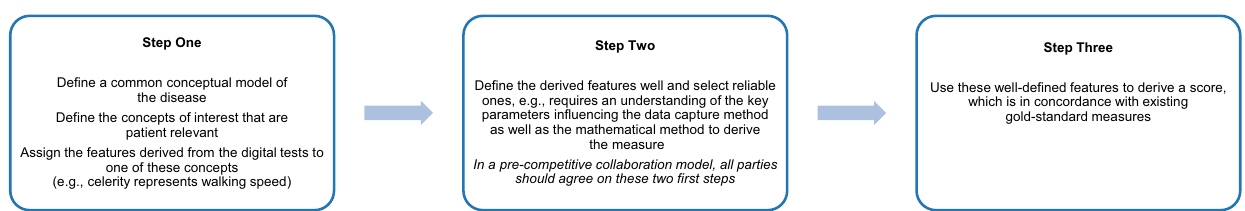
Fig. 3 Summary of steps involved in the development of a validated digital endpoint. Three steps to develop a validated score for use as a digital